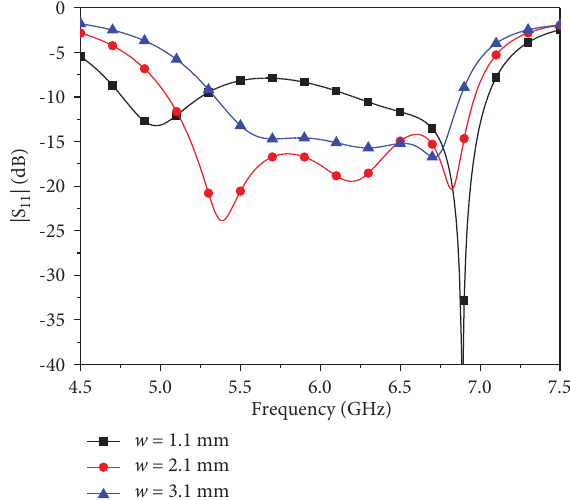
Figure 5: | S 11 | of the proposed antenna for different